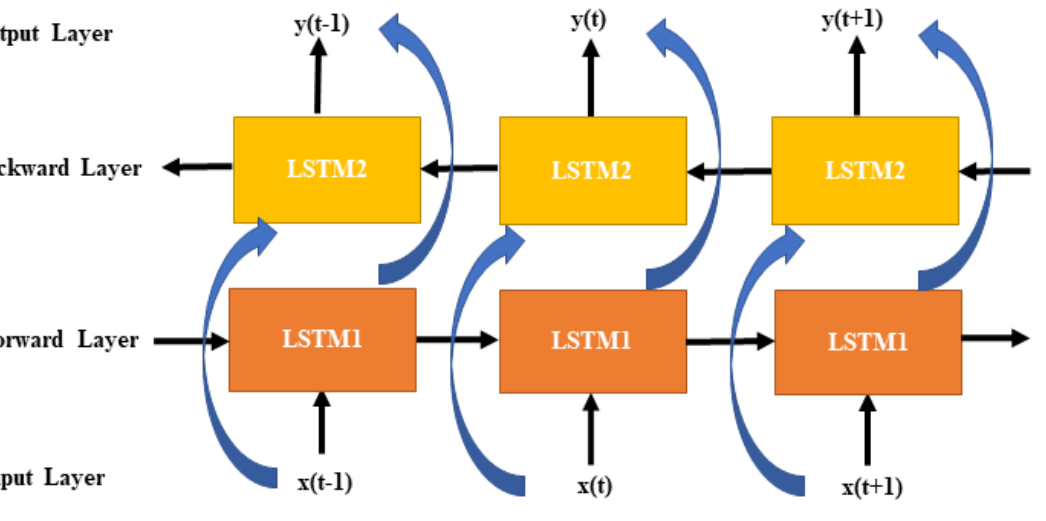
Figure 6. Single-layered Bi-LSTM.